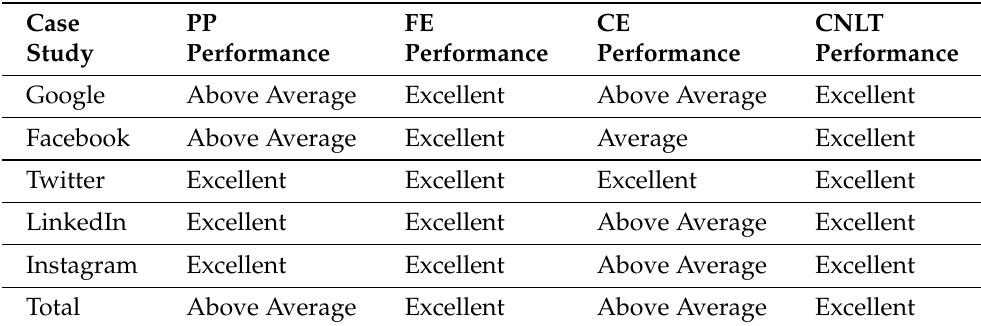
Table 4. Policy Parser (PP), Fragment Extractor (FE), Context Extractor (CFE) and Controlled Natural Language Translator (CNLT) performance evaluation against success rate.